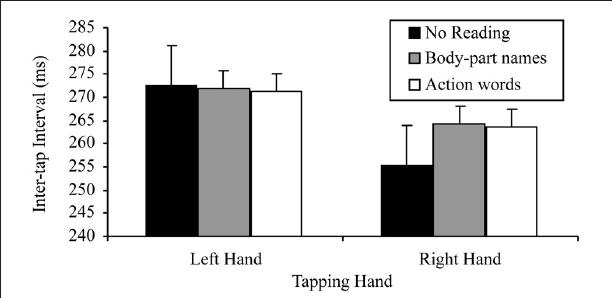
FIGURE 5 | Mean inter-tap intervals of each hand under the different reading conditions in the reading silently data set (error bars represent one standard error of the